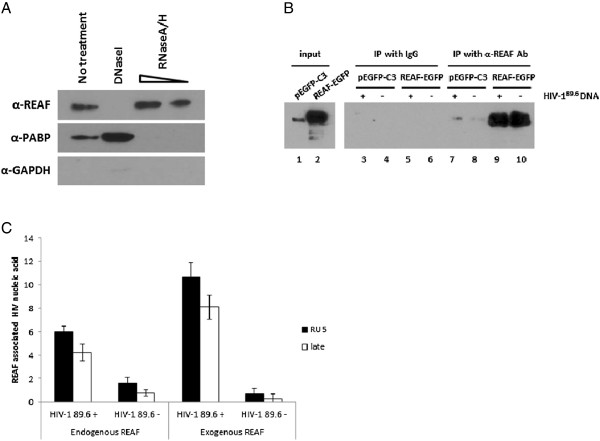
REAF interacts with viral nucleic acids. (A) Oligo d(T) immunoprecipitation of HeLa-CD4 cell lysate shows that REAF associates with captured RNA. Cell lysate was treated with DNase or titrated RNaseA/H before incubation with oligo (dT) beads. Immunoprecipitated protein was analysed by Western blotting and probed for REAF along with positive (PABP) and negative (GAPDH) controls. (B) HEK 293 T cells were transiently transfected with pEGFP-C3 or REAF-EGFP and the Western blot probed with α-REAF antibody. Endogenous and exogenous REAF are detectable in input samples (lanes 1 and 2) and following IP of samples transfected with pEGFP-C3 (endogenous REAF; lanes 7 and 8) or REAF-EGFP (endogenous and exogenous REAF; lane 9 and 10) with α-REAF antibody, but not after IP with IgG alone (lanes 3–6). (C) The amount of RU5 or late HIV-1 DNA qPCR product is quantified and normalised to input and IgG negative controls. Endogenous REAF associates with viral nucleic acids and this is enriched in the cells over-expressing REAF-EGFP.